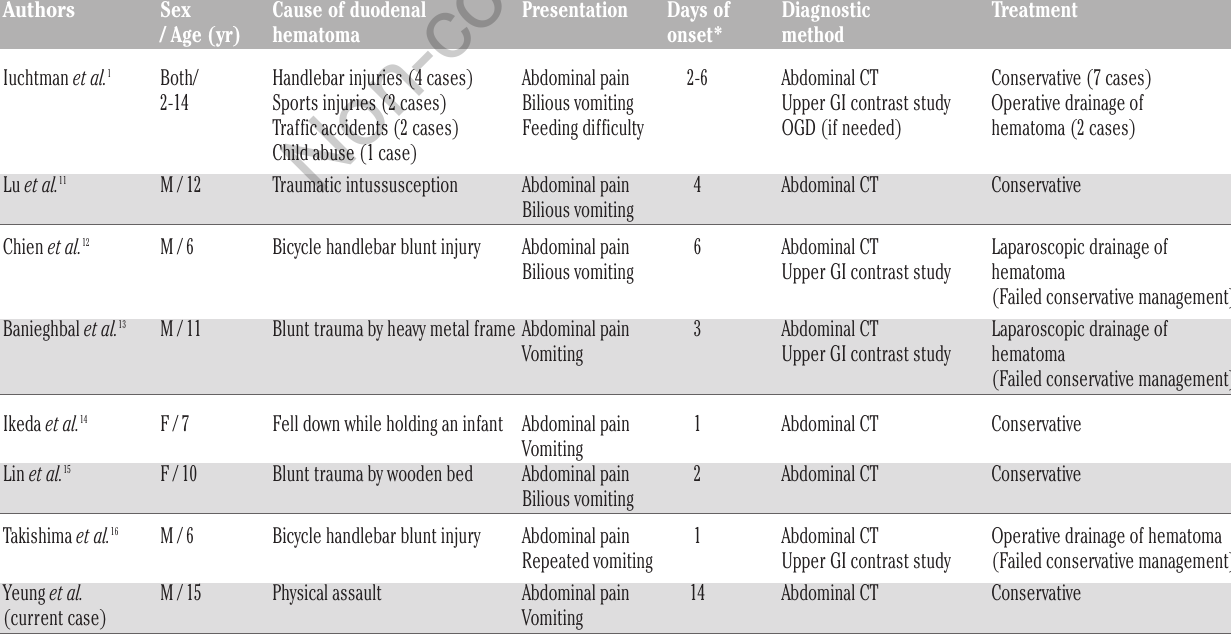
Table 1. Clinical presentation and management of traumatic duodenal hematoma in published articles within the last ten years.